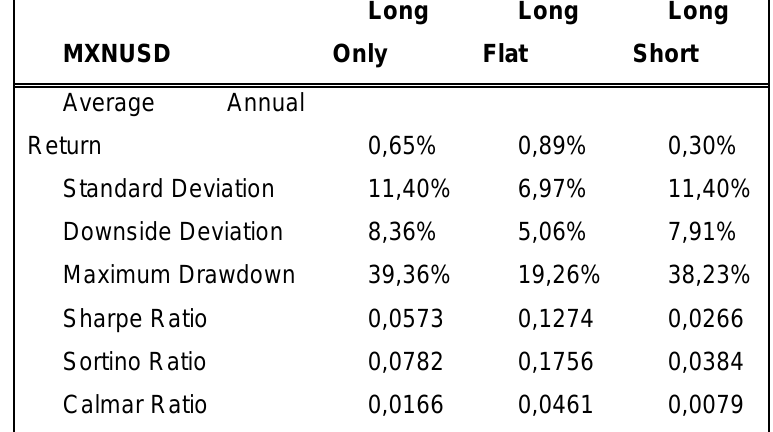
Table 1 : Results of the carry strategies on the MXN 5:2000-5:2018, daily data. Long Long Long MXNUSD Only Flat Short Average Annual Return 0,65% 0,89% 0,30% Standard Deviation 11,40% 6,97% 11,40% Downside Deviation 8,36% 5,06% 7,91% Maximum Drawdown 39,36% 19,26% 38,23% Sharpe Ratio Sortino Ratio 0,0782 0,1756 Calmar